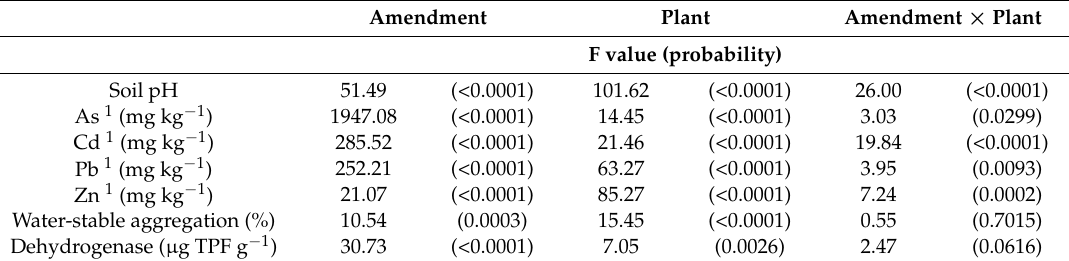
Table 2. Interaction of amendment and plant family on soil characteristics (soil pH, heavy metals and metalloids concentration, water-stable aggregation, and dehydrogenase activity) analyzed by a two-way ANOVA.